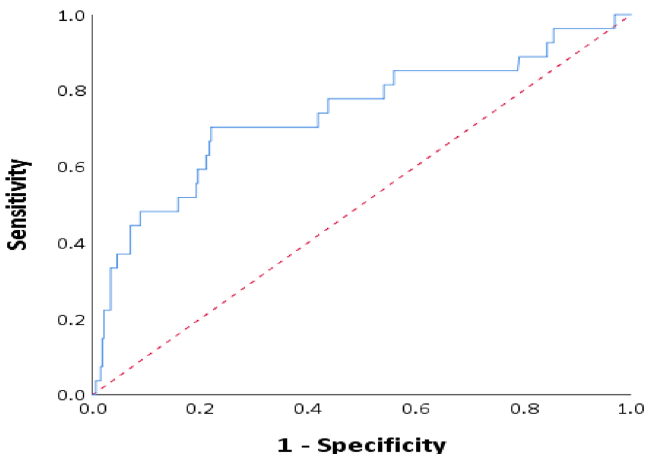
Figure 2. Receiver operating characteristic (ROC) analysis of diagnosis of venous thromboembolism by D-dimer value/age-adjusted upper normal limit ratio in hospitalized patients (AUC 0.74, 95% CI = 0.62–0.85). The Red dashed line represents the identity line (positive D-dimer values obtained during hospitalization; venous thromboembolism was diagnosed during the hospitalization or within 3 months of